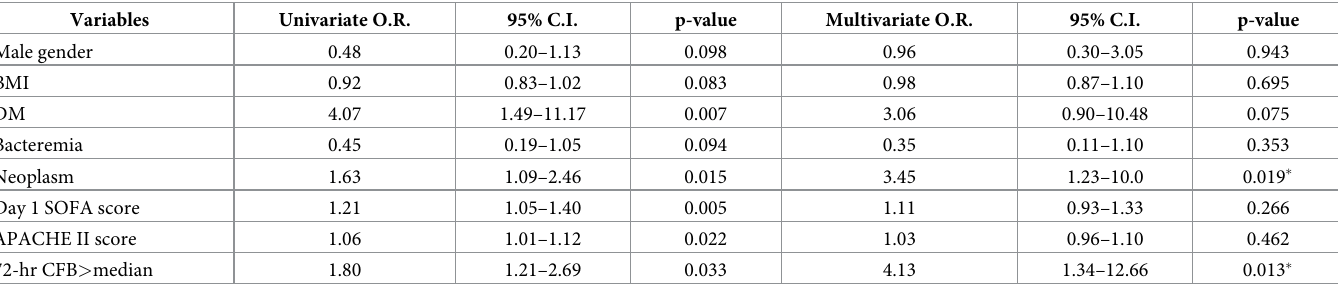
Table 3. Univariate and multivariate analysis of risk factors associated with 28-day mortality in patients with septic shock. Variables Univariate